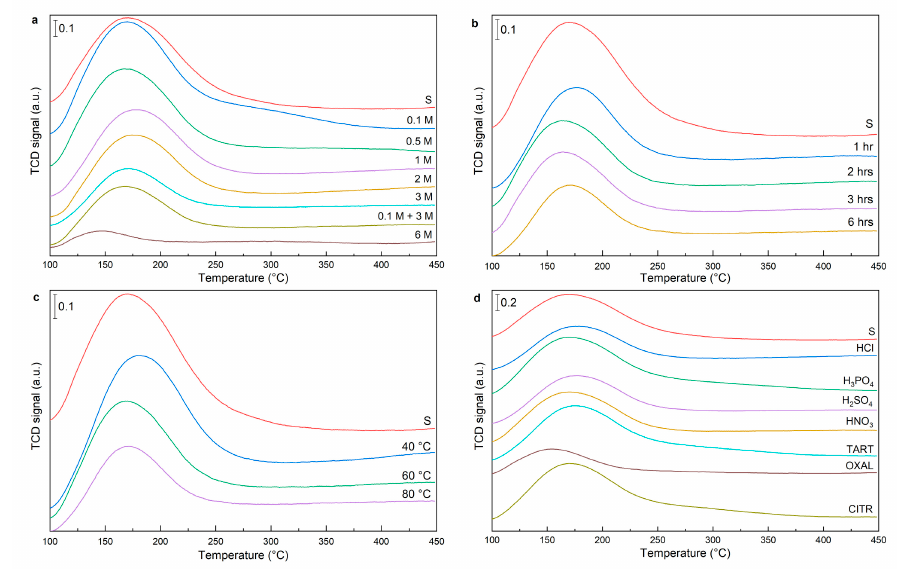
Figure 6. NH 3 -TPD of acid leached zeolite foams: Influence of acid concentration ( a ), time ( b ), temperature ( c ), and type of acid ( d